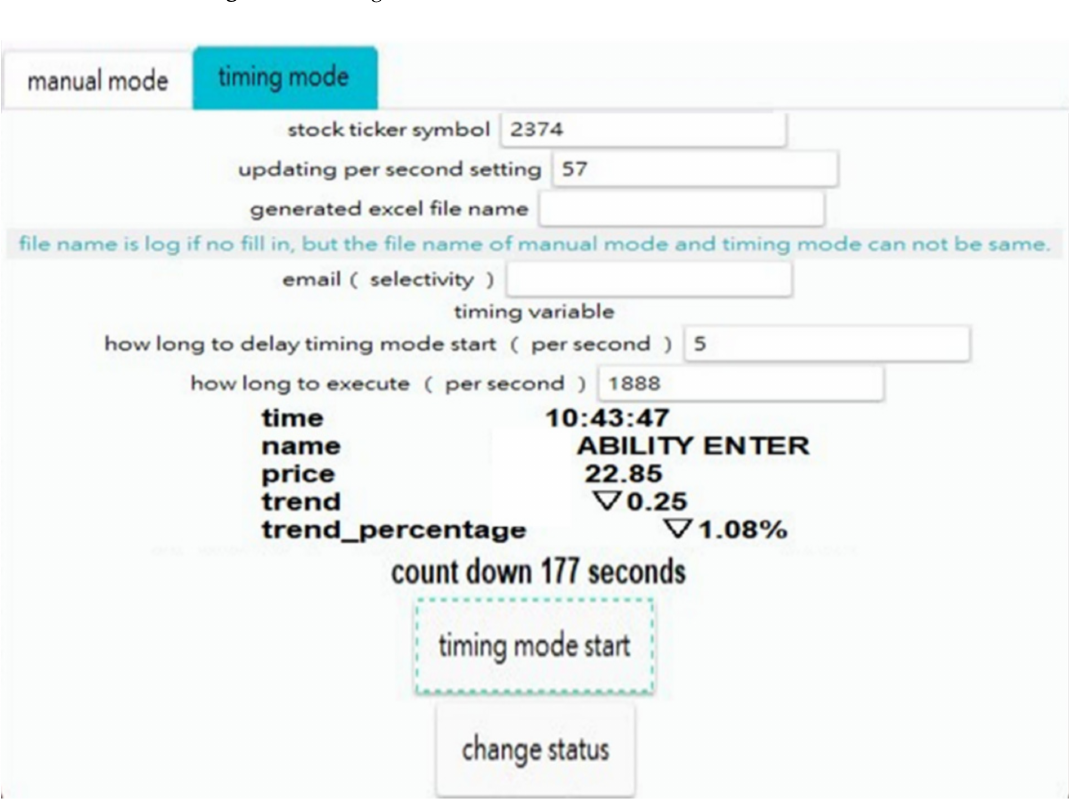
Figure 13. Timing mode count down 995 s.